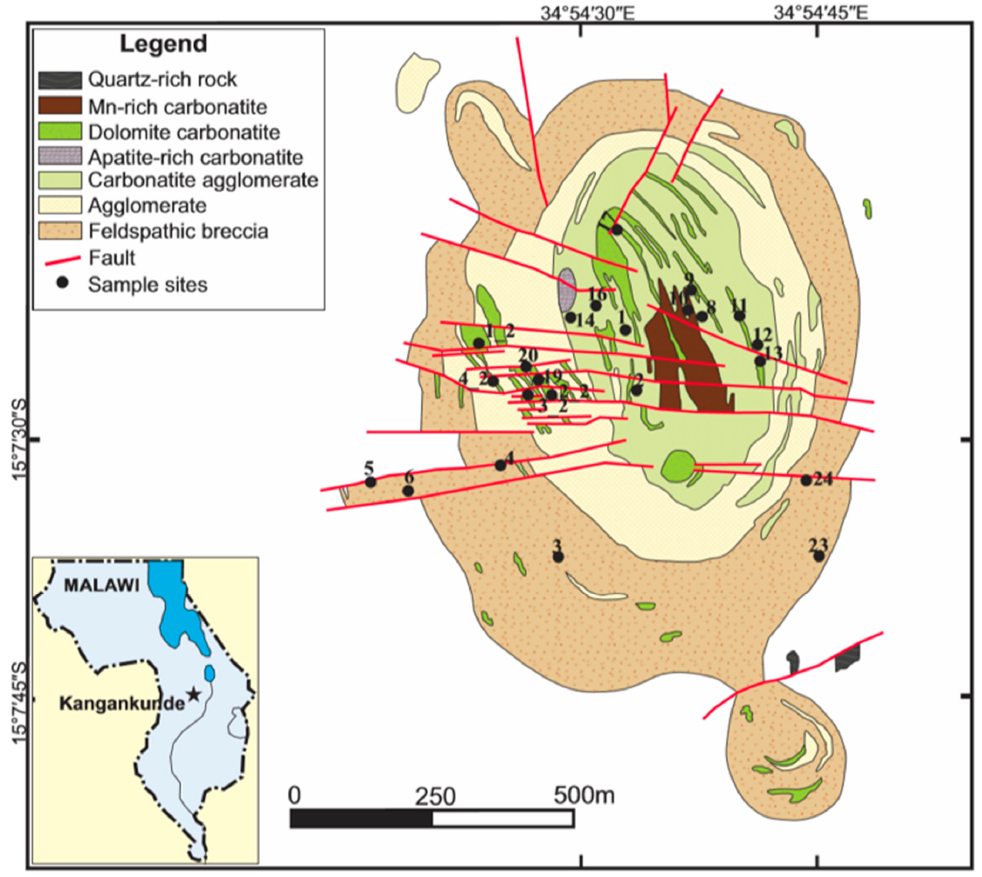
Figure 1. Geological map of the Kangankunde carbonatite complex showing sample locations (after Broom-Fendley et al. [5,15]). Inset shows the location of Kangankunde in Malawi,